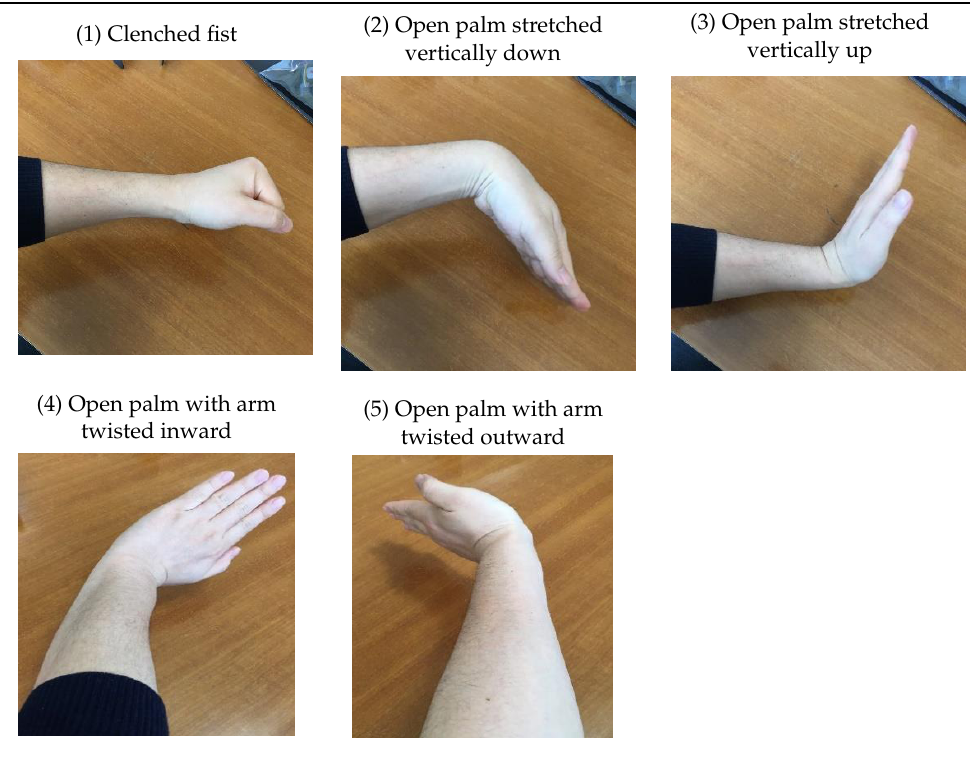
Table 1. Hand gesture for EMG data Table 1. Hand gesture for EMG data acquisition. Table 1. Hand gesture for EMG data acquisition. Table 1. Hand gesture for EMG data acquisition. Table 1. Hand gesture for EMG data acquisition. Table 1. Hand gesture for EMG data acquisition.